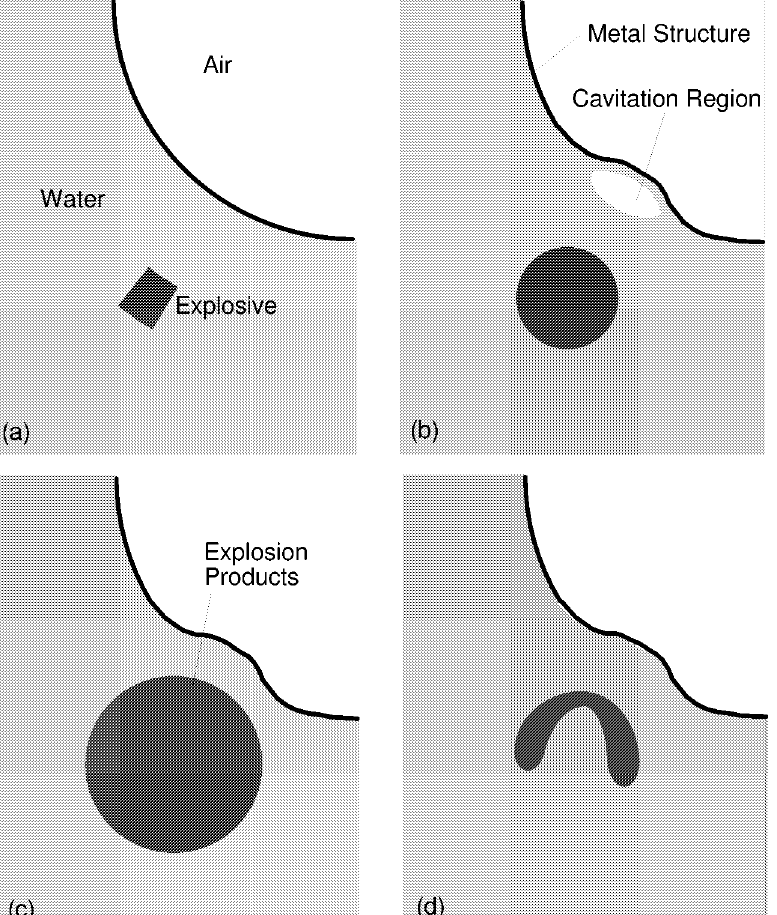
Fig. 1. UNDEX-SMI analysis